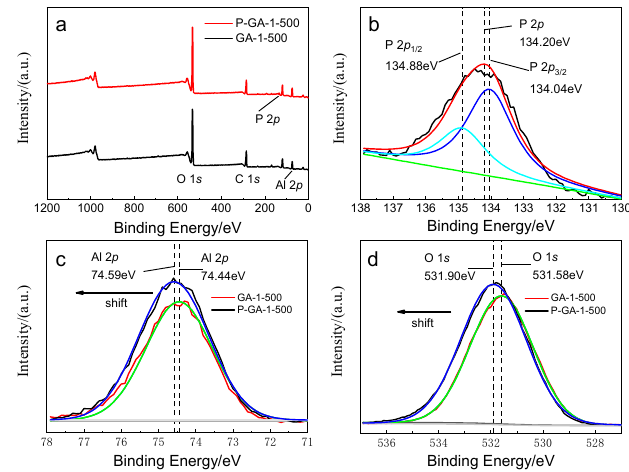
Figure 10. The X-ray photoelectron spectroscopy (XPS) analysis of GA-1-500 before and after phosphorus adsorption. ( a ) XPS full-scan spectra; ( b ) P 2 p of P-GA-1-500; ( c ) Al 2 p ( d ) O 1 s.